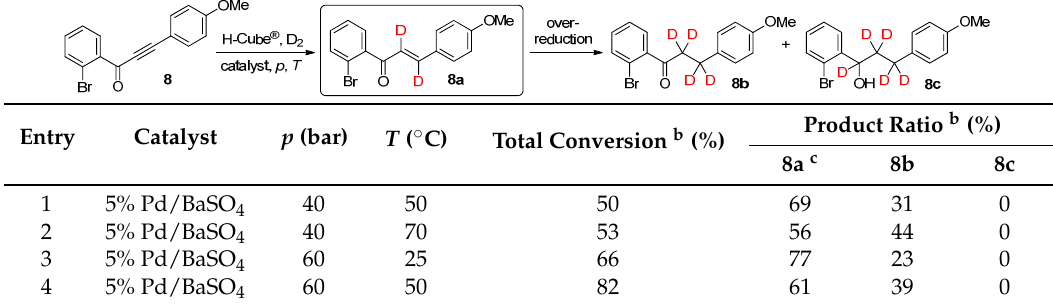
Table 4. Continuous-flow deuteration of 8 a .